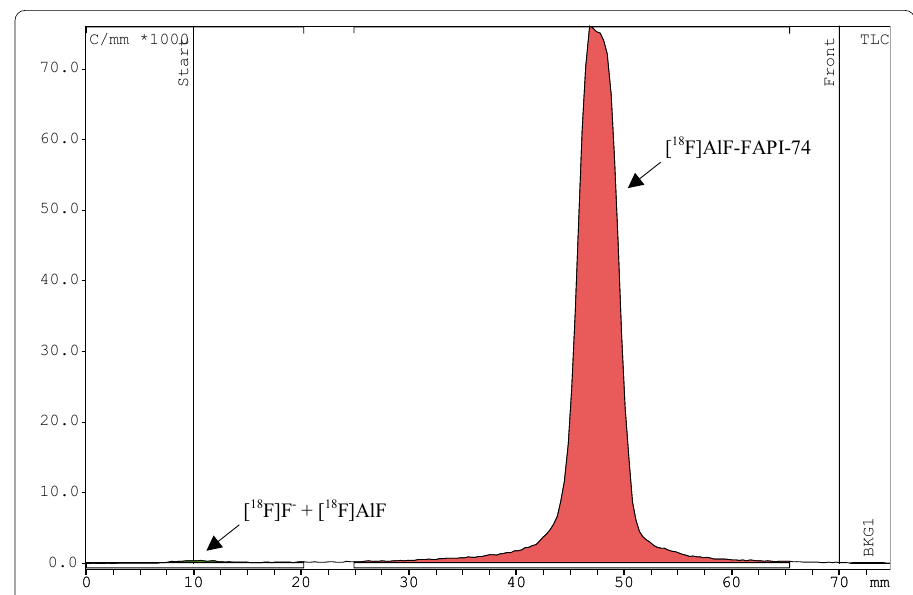
Fig. 5 TLC chromatograms of [ 18 F]AlF-FAPI-74 with 10 mM phosphate buffered saline (pH 6.7) containing 100 mg sodium ascorbate as a formulation solution. [ 18 F]fluoride or [ 18 F]AlF peak is appeared near the origin (Rf 0) and Rf of [ 18 F]AlF-FAPI-74 is approximately 0.6–0.7 =